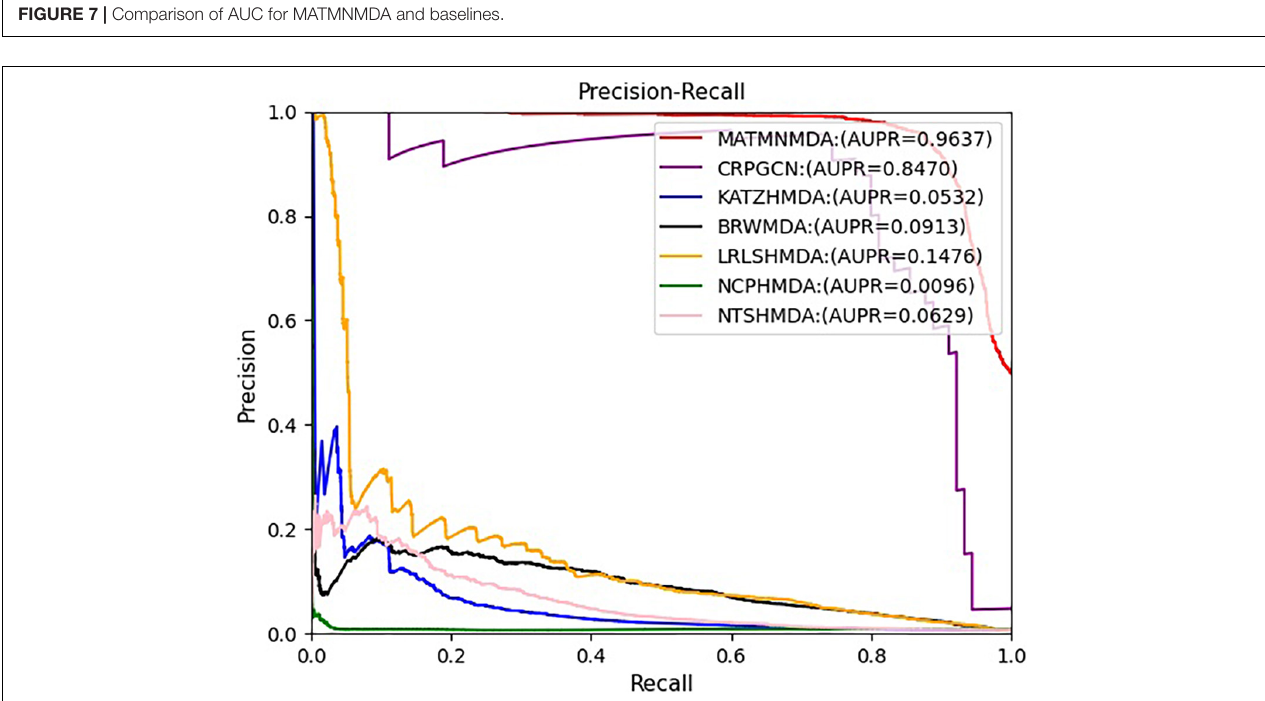
FIGURE 8 | Comparison of AUPR for MATMNMDA and